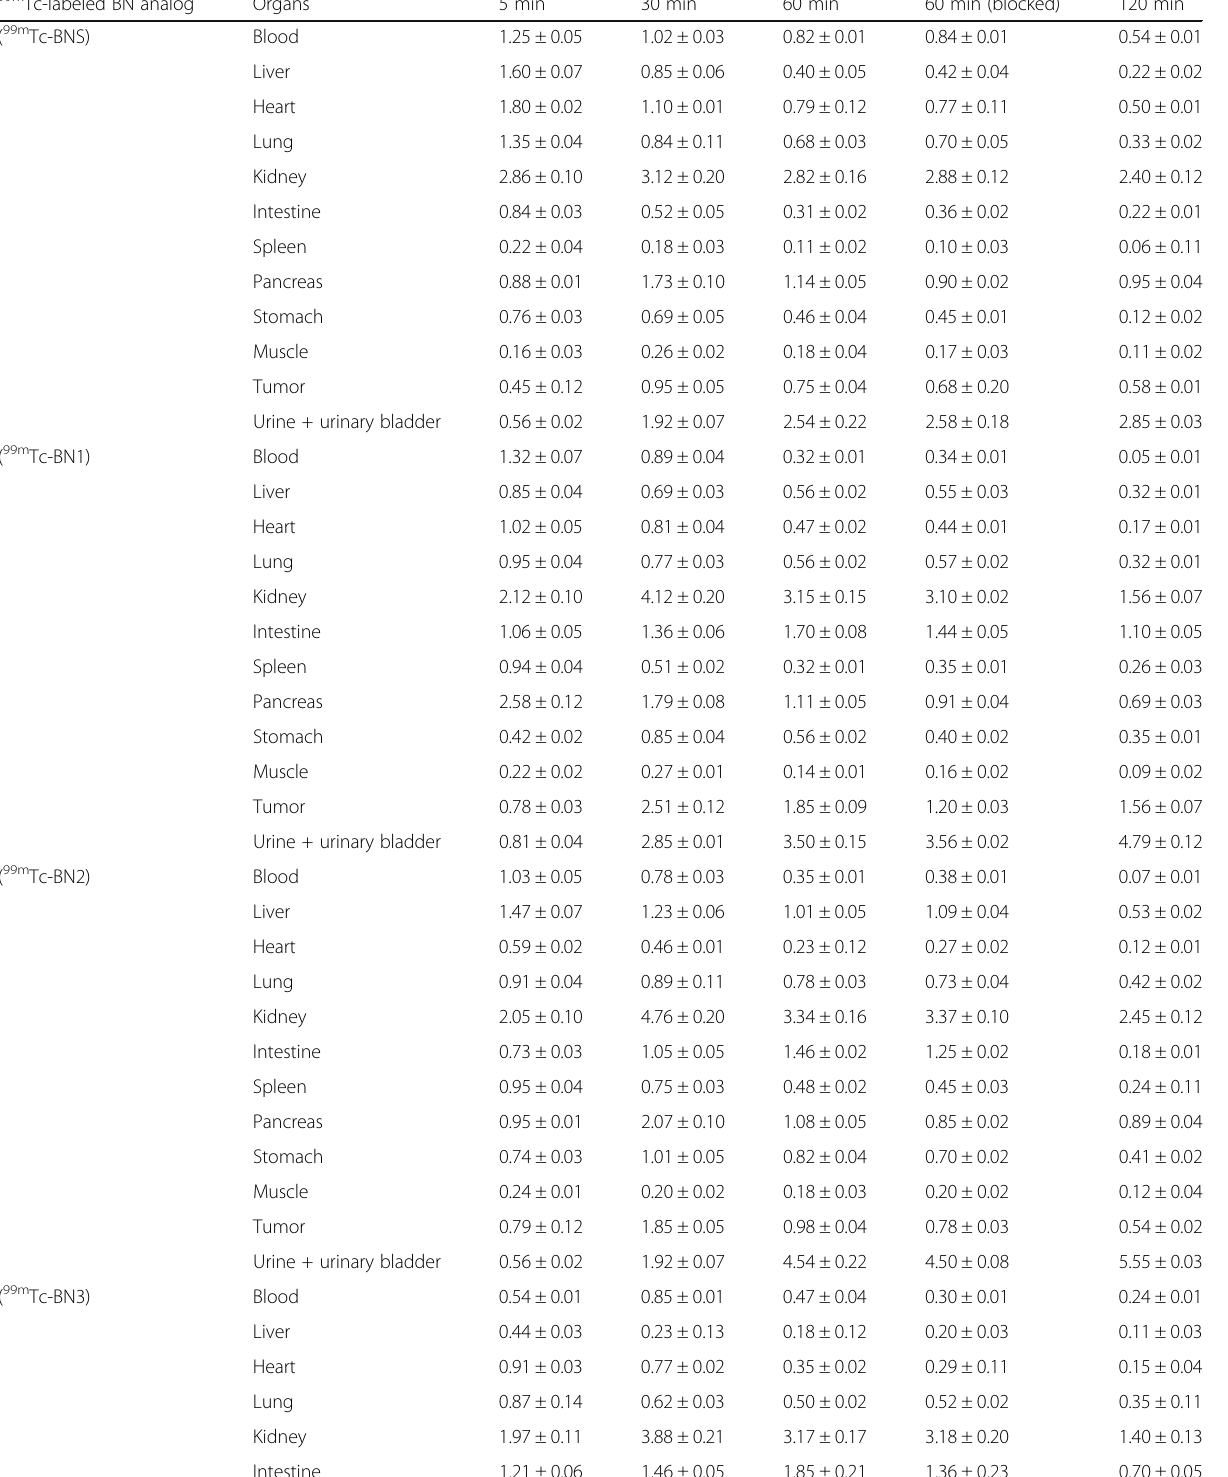
Table 2 Biodistribution data of the 99m Tc-labeled standard bombesin (BNS) and new bombesin analogs (BN1, BN2, BN3, BN4) in tumor-bearing mice at 5, 30, 60, and 120 min post-injection (PI). All the data represent %IA/g (mean ± SD) value and are the mean of results from three animals per time